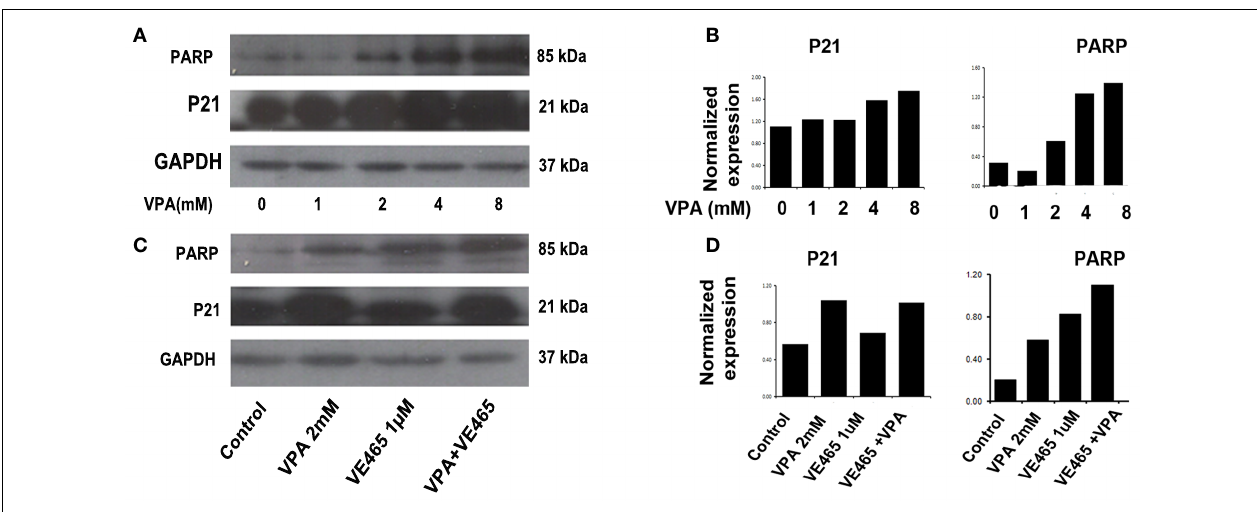
induced cleaved PARP and P21 expression in a dose-dependent manner. (C,D) Co-treatment withVPA andVE465 induced more expression of cleaved PARP, but not of P21, than treatment withVPA orVE465